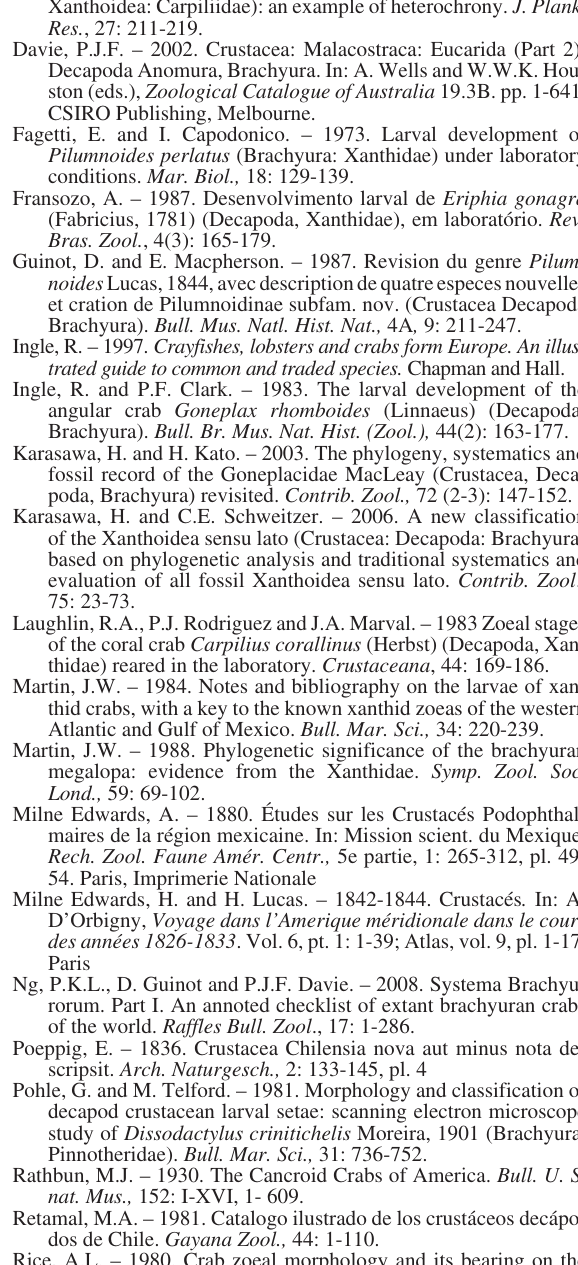
Table 6. – difference between the morphology of zoea i of Pilum- noides hassleri and Eriphia scabricula dana, 1852 by Clark